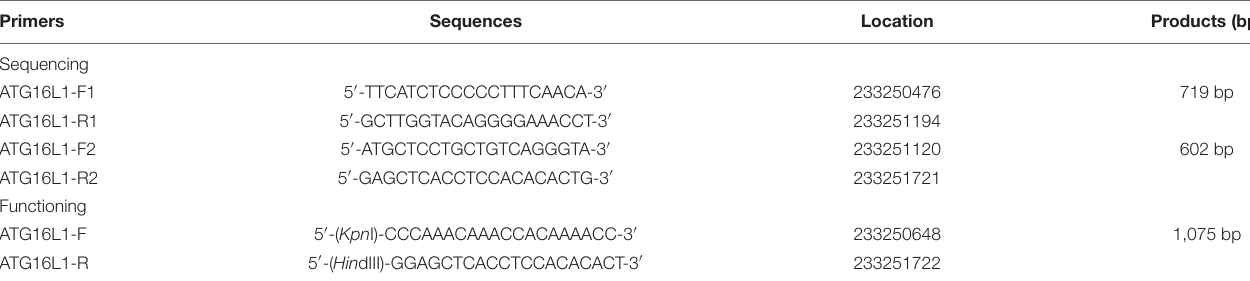
TABLE 1 | PCR primers for the human ATG16L1 gene